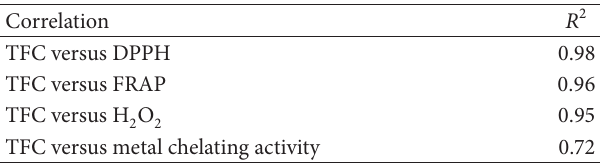
Table 4: Correlation between total flavonoid contents (TFC) and antioxidant activities of date extracts.